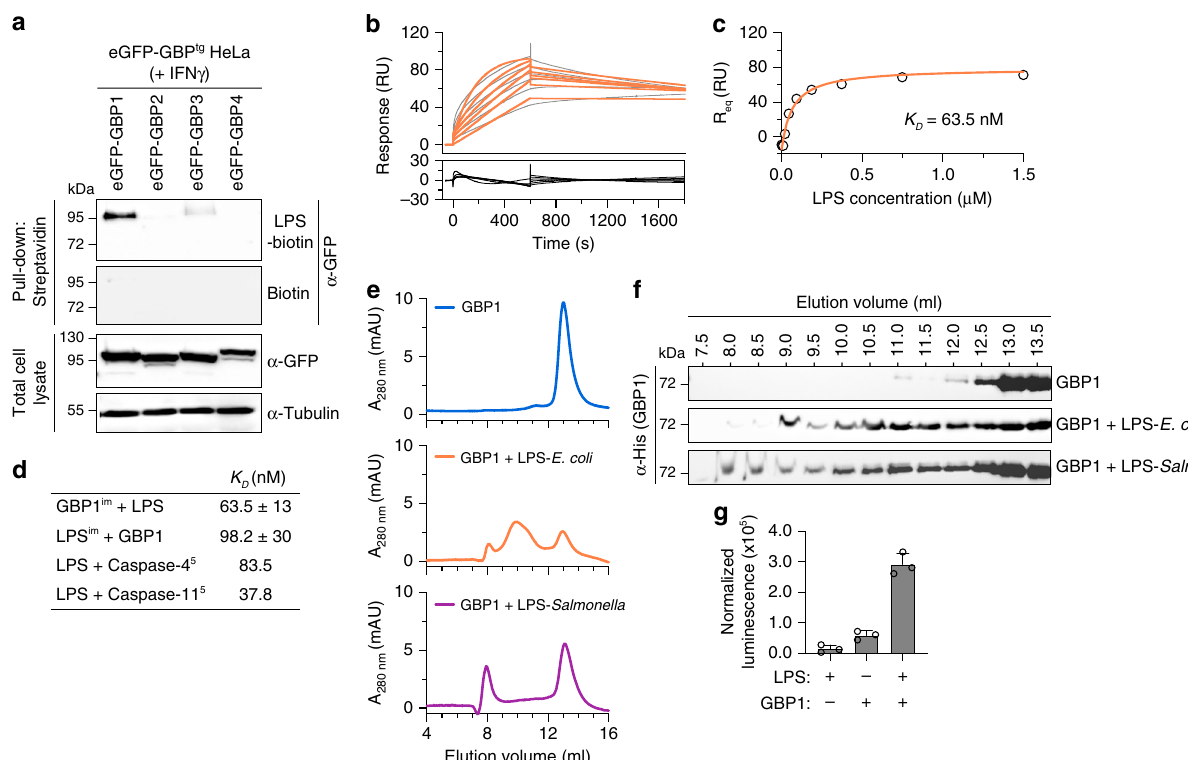
Fig. 6 LPS binds to GBP1 to induce formation of a high-molecular weight protein complex. a Streptavidin pull-down assay for eGFP-GBP1-4 using biotin or biotin-conjugated LPS. HeLa cells stably expressing Dox-inducible eGFP-GBP1, − 2, − 3, or − 4 were primed with IFN γ and 1 µ g/mL Dox was added for 16 h. 1 million cells were lysed and incubated with 2 µ g LPS-biotin or biotin, and the biotinylated substrates were pulled down using equal amounts of streptavidin magnetic beads, which were then eluted in equal volumes of SDS-PAGE reducing sample buffer. Streptavidin-bound and -unbound fractions were analyzed by western blot using an antibody against GFP. b SPR sensorgram of E. coli LPS (O111:B4) binding to human GBP1 immobilized on a CM5 chip surface. Sensorgram was obtained by using different LPS concentrations (47, 94, 188, 375, 750, and 1500 nM). Gray lines correspond to SPR data and orange lines to model fi ts using a two-state-reaction model. c Saturation curve of the titration of LPS on GBP1 immobilized on a CM5 chip. d Calculated dissociation constants ( K D ) for LPS binding to immobilized GBP1 (GBP1 im ) or GBP1 binding to immobilized E. coli LPS (LPS im ). Dissociation constants for LPS-caspase-4 and LPS-caspase-11 were previously published by Shi et al. 5 . e , f Size exclusion chromatograms of recombinant, LPS-free His-tagged GBP1 incubated with various LPS derivatives. Following puri fi cation, GBP1 (1 µ M) was incubated on ice with LPS (2 µ M) for 5 h before being subjected to size- exclusion analysis on a Superdex 200 10/30 GL column. Protein size was estimated using molecular weight standards. Curves were corrected by subtracting LPS-speci fi c absorbance at 280 nm. Individual fractions were run on a 12% acrylamide gel and immunoblotted against His 6 to con fi rm the presence of GBP1 in elution peaks ( f ). g GTPase activity analysis of recombinant GBP1. GBP1 (500 nM) was incubated with GTP (5 µ M) with or without ultrapure LPS (5 µ M) for 30 min before the reaction was stopped. Luminescence was normalized to a buffer-only control. Graphs show the mean ± SD, and data are representative from three ( a – d , g ) or fi ve ( e , f ) independent experiments performed with at least three independently expressed and puri fi ed batches of recombinant His-GBP1.